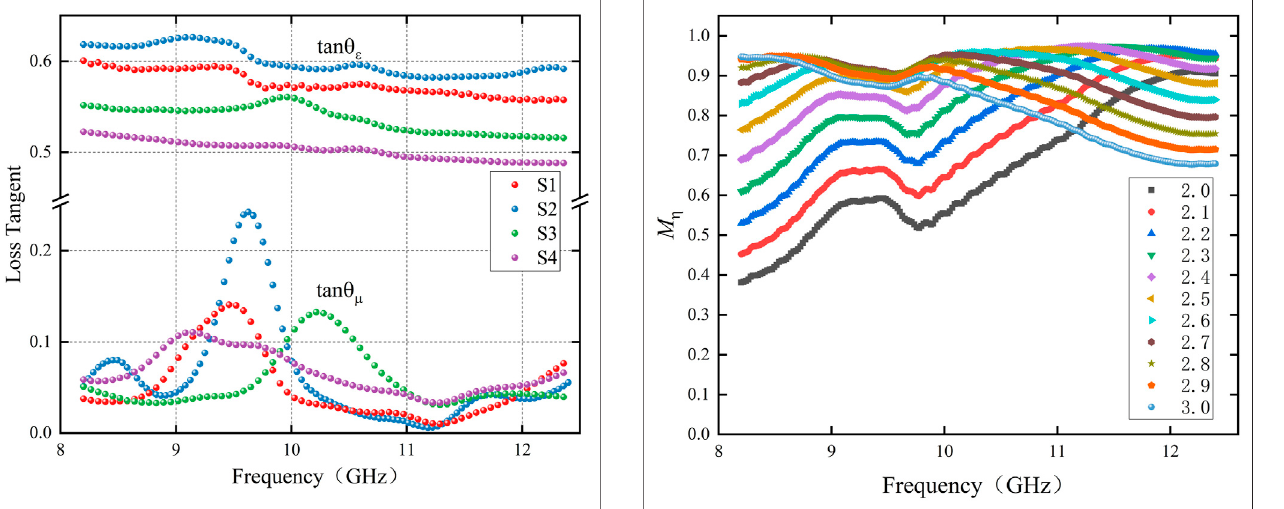
FIGURE 9 | Plots of dielectric and magnetic loss tangent for all samples.